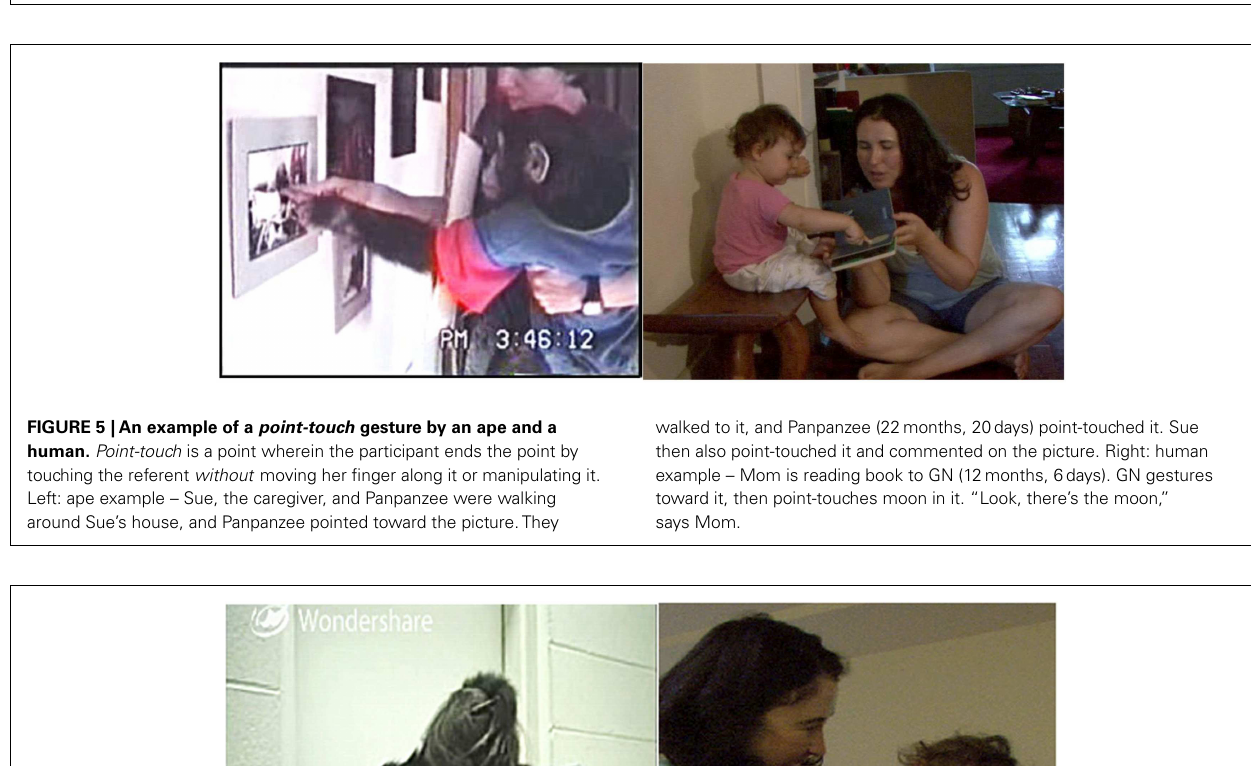
FIGURE 4 | Examples of a point gesture. Point involves extending an arm with the index finger extended toward an object without touching it. Left: ape example –The caregiver asks Panpanzee (22months, 20days) where she wants to go and she points toward the car.They walk toward the car. Right: